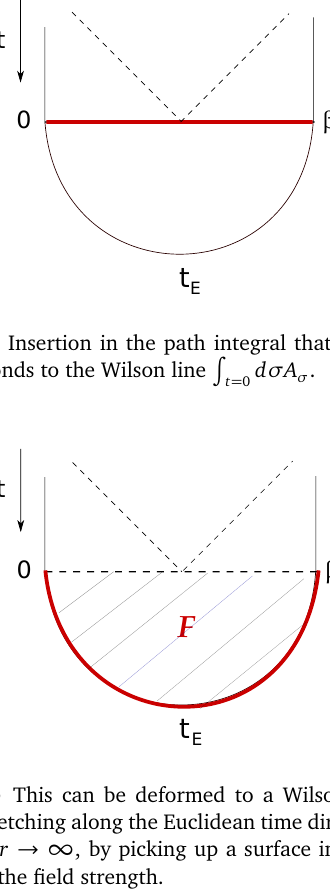
Figure 6: Path integral evaluation of the Wilson line action on the thermofield double